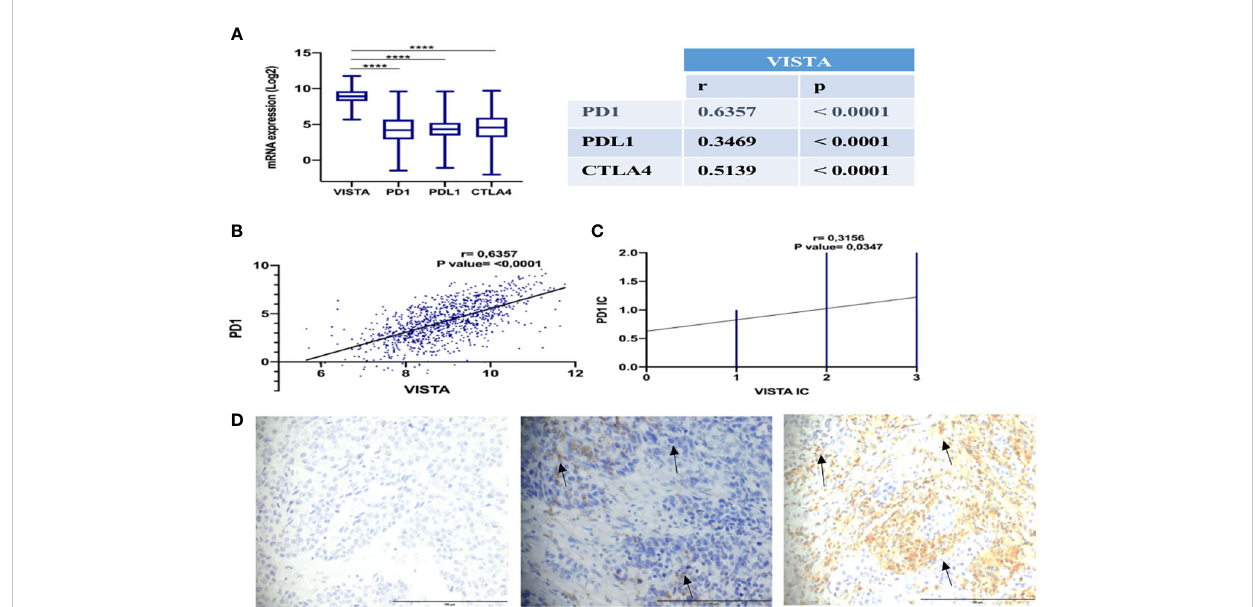
FIGURE 6 Positive correlation of VISTA and PD-1 expression in breast cancer patients. (A) Expression and correlation of VISTA mRNA with PD-1, PDL-1, and CTLA-4 in TCGA dataset. (B) Correlation of VISTA and PD-1 in TCGA cohort (r=0,4605, P-value <0,001). (C) Correlation of VISTA and PD-1 in immune cells by IHC in the Moroccan cohort (r=0,3156, P-value= 0.0347). (D) IgG1 negative control isotype staining in a TNBC patient is represented on the left, followed by PD-1 positive staining in the middle, and VISTA positivity staining on the right (magni fi cation ×40). Scale bare 100 µm. ****Indicates p-value < 0.0001. The black arrows signify VISTA and PD1 expression on immune